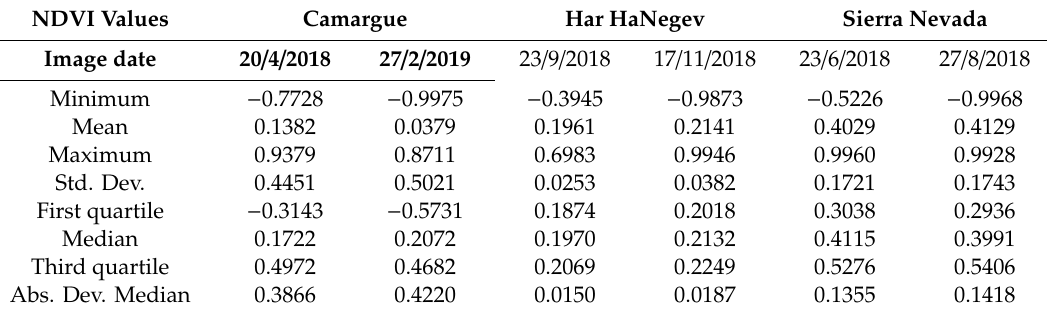
Table 7. Statistical descriptions of the NDVI values computed using two scenes per protected area at the original 10 m